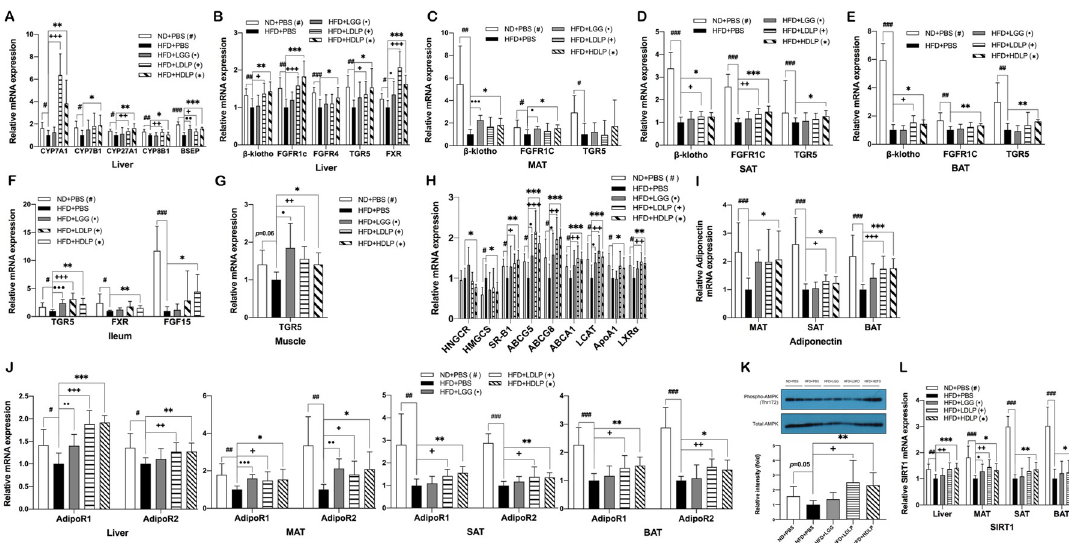
Fig 2. L . plantarum treatment improves bile acid synthesis and reverse cholesterol transport. Effects of L . plantarum treatment on mRNA expression of (A) genes involved in bile acid synthesis in the liver, (B-G) bile acid and FGF15 receptors in the liver, MAT, SAT, BAT, ileum, and skeletal muscle, respectively, (H) genes related to RCT in the liver, (I) adiponectin in adipose tissue, (J) adiponectin receptors in the liver and adipose tissue, and (L) SIRT1 in the liver and adipose tissue. Gene expression were analyzed by real-time PCR using gene-specific primers. The liver and adipose tissue genes are normalized to expression of β -actin, skeletal muscle and ileum genes are normalized to expression of Arbp. Data present mean ± SD for 7~8 mice in each group. (K) AMPK phosphorylation in the liver detected by SDS-PAGE-immunoblotting. Data present mean ± SD. of fold changes in blot intensity compare with HFD+PBS group. Student’s two-tailed t-test was used for analysis of differences between groups. #, •, +, � p < 0.05, ##, ••, ++, �� p < 0.01, ###, •••, +++, ��� p <